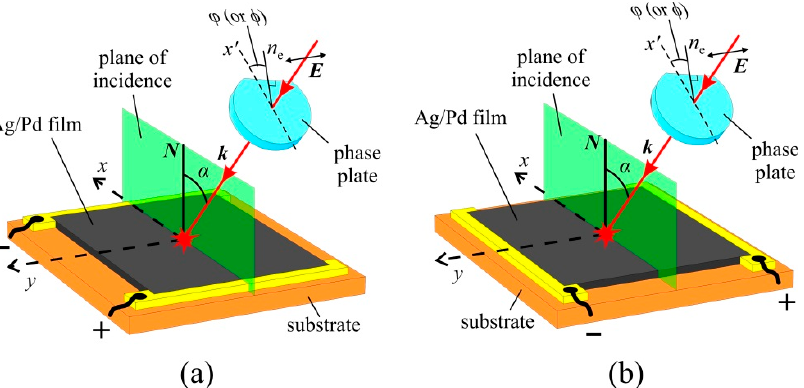
Figure 3. Sketch of the experiments for registration of the ( a ) longitudinal and ( b ) transverse photocurrents in the Ag/Pd nanocomposite films. The electrodes are oriented ( a ) perpendicular and ( b ) parallel to the plane of the incidence, which coincides with the xz plane of the laboratory Cartesian frame. E is the electric field vector of the beam before a wave plate, which is perpendicular to the plane of incidence, k is wave vector, n e is the slow axis of the wave plate, N is a unit vector of normal to the film surface, α is the angle of incidence, x ’ is an axis in the plane of incidence and perpendicular to the laser beam. The polarization of the exciting radiation was determined by the angle φ or ϕ of the orientation of the quarter-wave plate or half-wave plate, respectively.